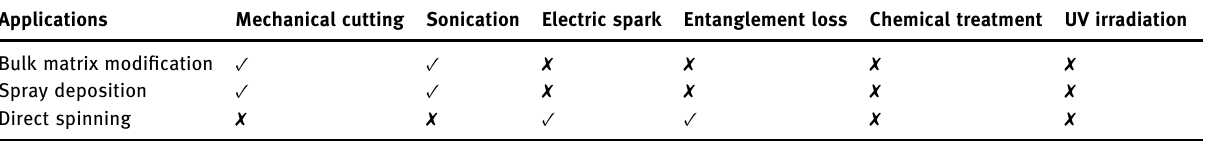
Table 3: Application of short nano fi ber preparation techniques in composite reinforcement